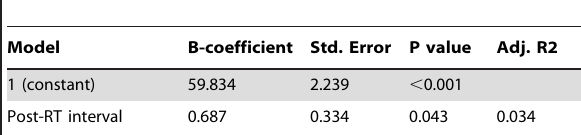
Table 3. Multiple linear regression analysis of age, gender, education, post-RT interval, and chemotherapy to SAS.